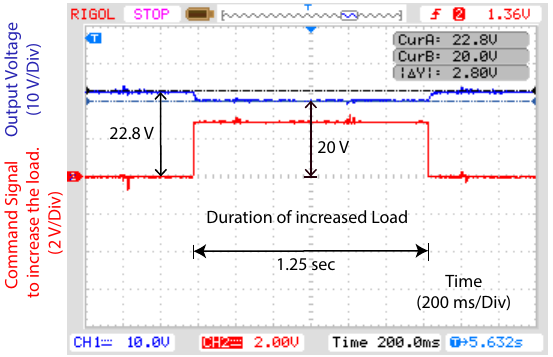
Figure 5. Output voltage of the boost converter in an open loop during rated load and full